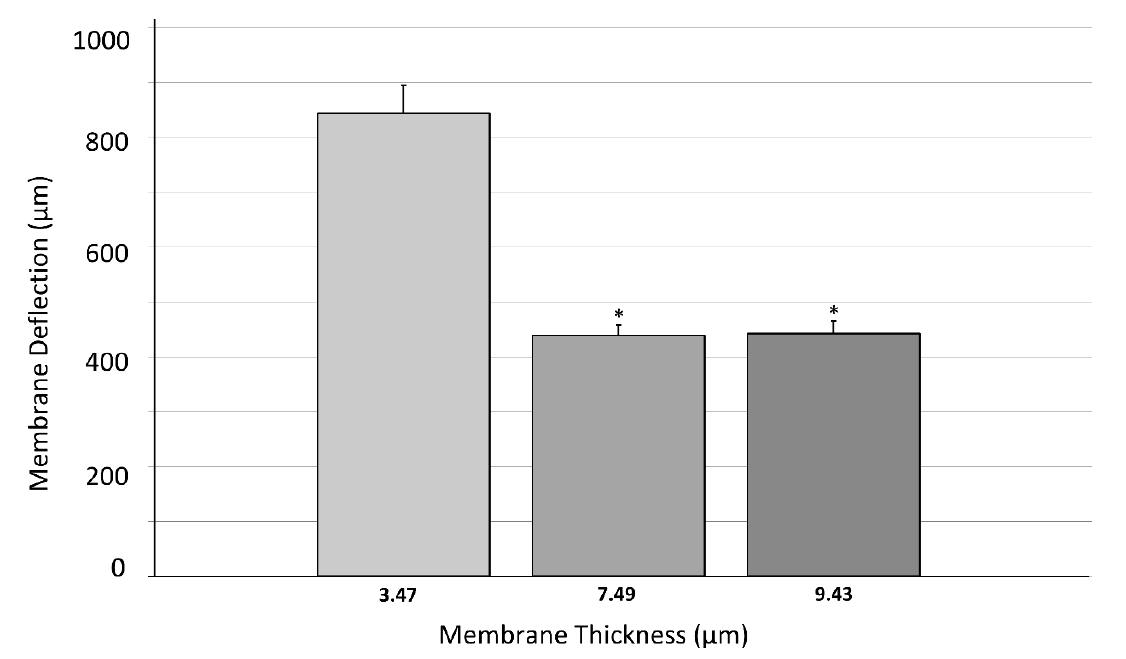
Table 5. Measured average deflection values of membranes with average membrane thicknesses ± standard deviation in µm.